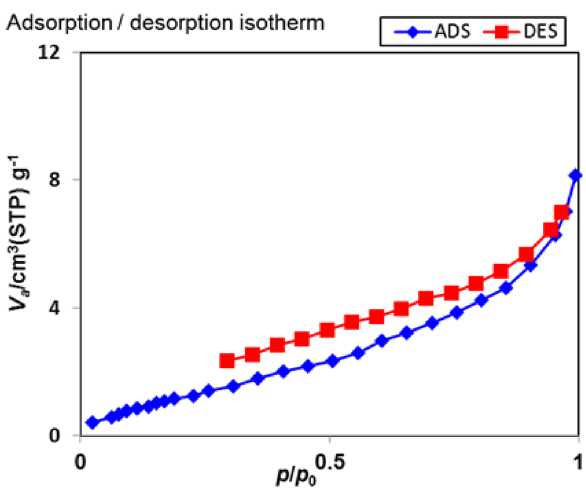
Figure 9. N 2 adsorption–desorption isotherms of Sm-bis(PYT)@boehmite.